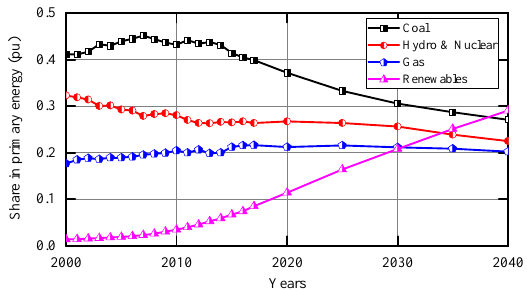
Figure 3. The global energy consumption trends and projection based on fuel share